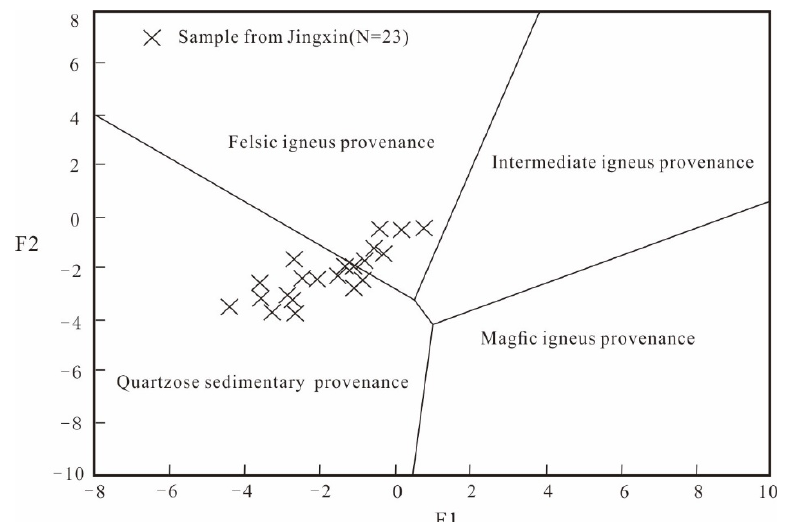
Figure 9. Major elemental composition discriminatory plots for the provenance of sandstones in Qamdo basin (F1 = − 1.773TiO 2 + 0.607Al 2 O 3 + 0.76Fe 2 OT 3 − 1.5MgO + 0.616CaO + 0.509Na 2 O − 1.224K 2 O − 9.09; F2 = 0.445TiO 2 + 0.07Al 2 O 3 − 0.25Fe 2 OT 3 − 1.142MgO + 0.438CaO + 1.475Na 2 O + 1.426K 2 O − 6.861, after Roser et al., 1988 [67]).